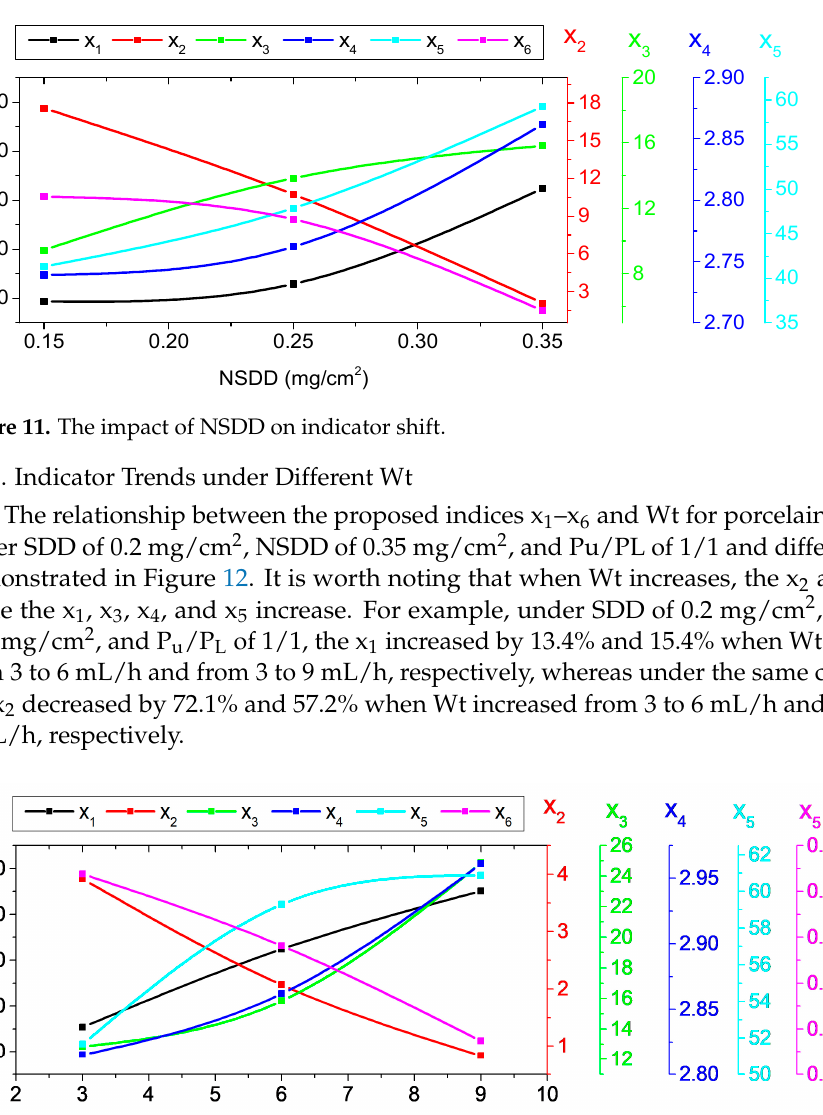
Figure 10. Leakage current indices of uniform polluted insulators under various wetting rate Wt and NSDD: ( a ) x 1 ; ( b ) x 2 ; ( c ) x 3 ; ( d ) x 4 ; ( e ) x 5 ; ( f ) x 6 .